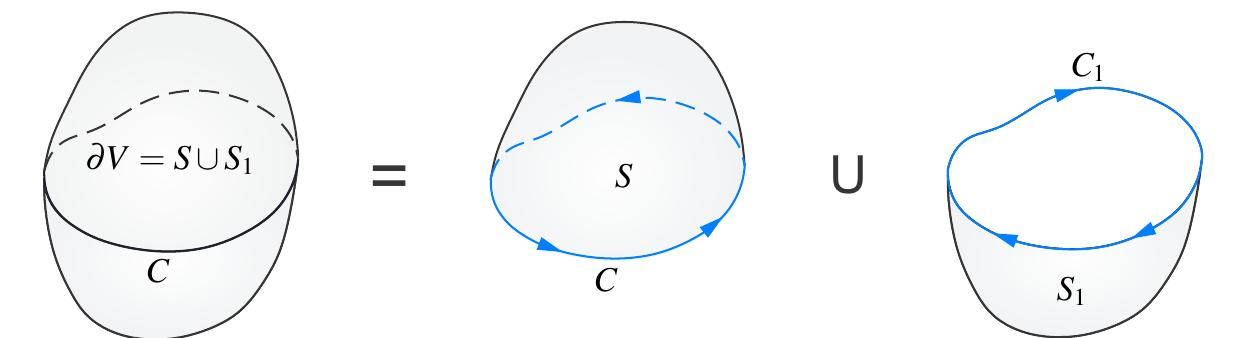
Figure 4. Closed surface ∂ V that bounds volume V is union of two surfaces S and S 1 . Contour C bounds surface S and contour C 1 bounds surface S 1 . Contours C and C 1 are identical; however they have different Stokes’